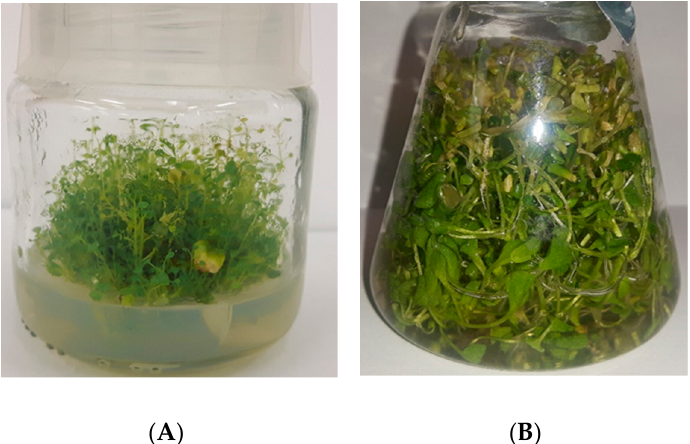
Figure 1. The microshoot cultures of N. officinale . ( A ) Agar microshoot culture; MS medium containing 1 mg/L BA and 1 mg/L NAA, 30th day of culture growth. ( B ) Agitated microshoot culture; MS 1 mg / L BA and 1 mg / L NAA, 30th day of culture growth. ( B ) Agitated microshoot culture; MS medium medium containing 1 mg/L Zea and 1 mg/L NAA, 20th day of culture growth. containing 1 mg / L Zea and 1 mg / L NAA, 20th day of culture